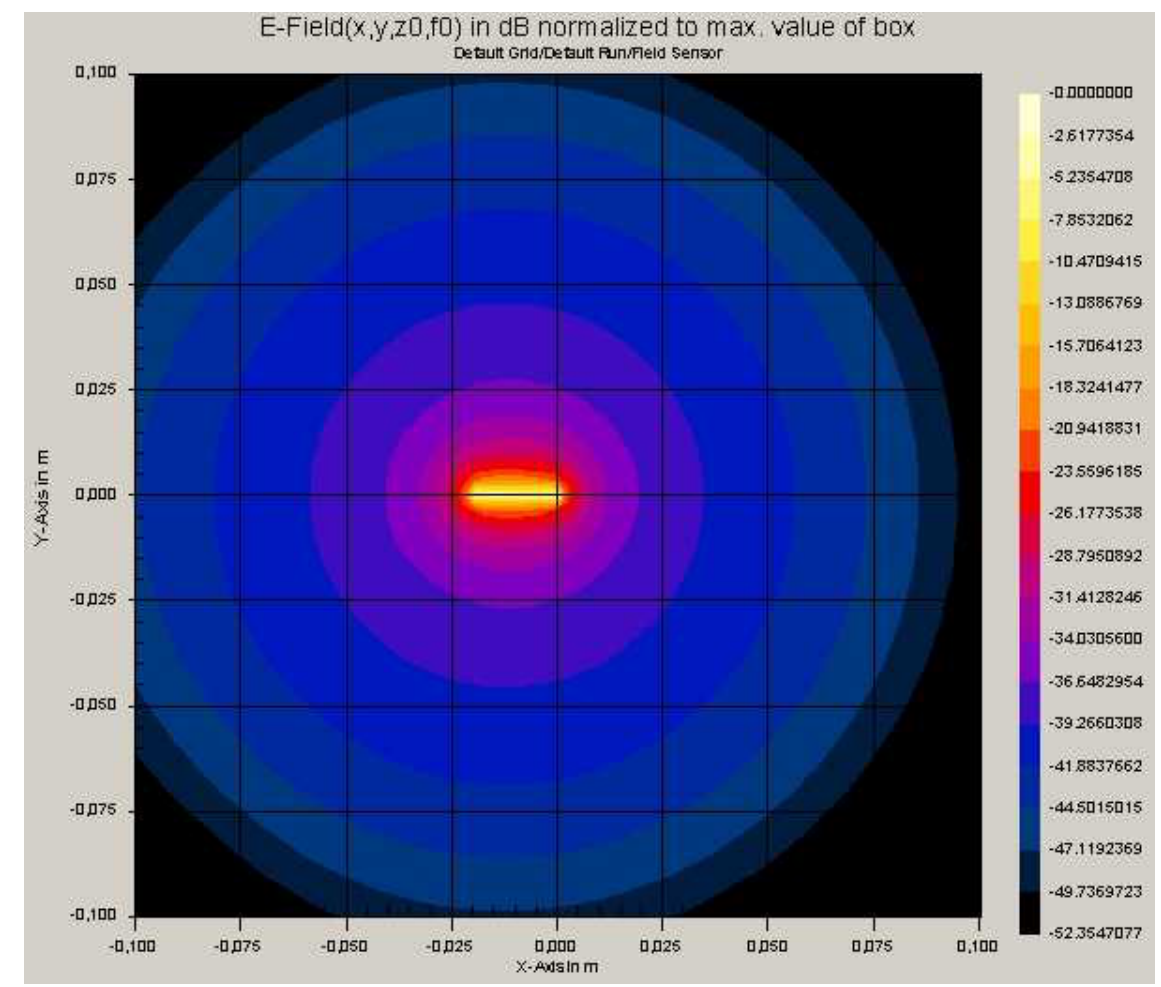
FIGURE 2. Near field of the dipole at the azimuth (xy) level as calculated by the FDTD